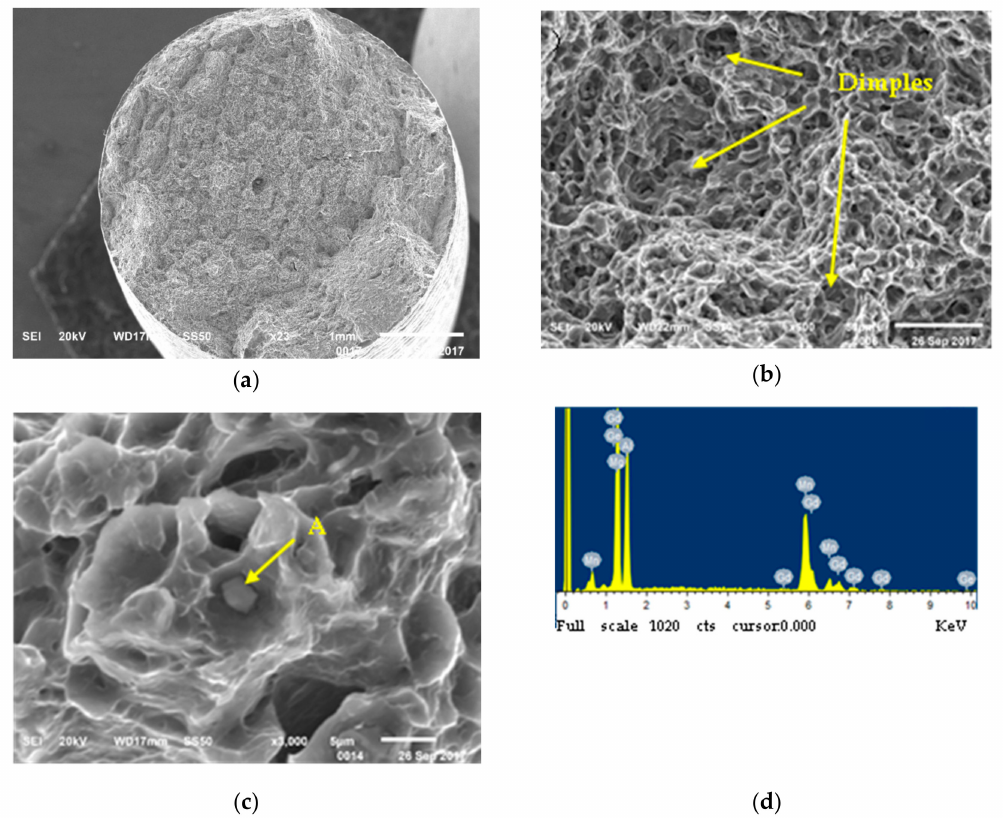
Figure 9. Fractographies of the SSRT test sample in air: ( a ) × 23, ( b ) × 500, ( c ) × 3000, and ( d ) EDS results of Point